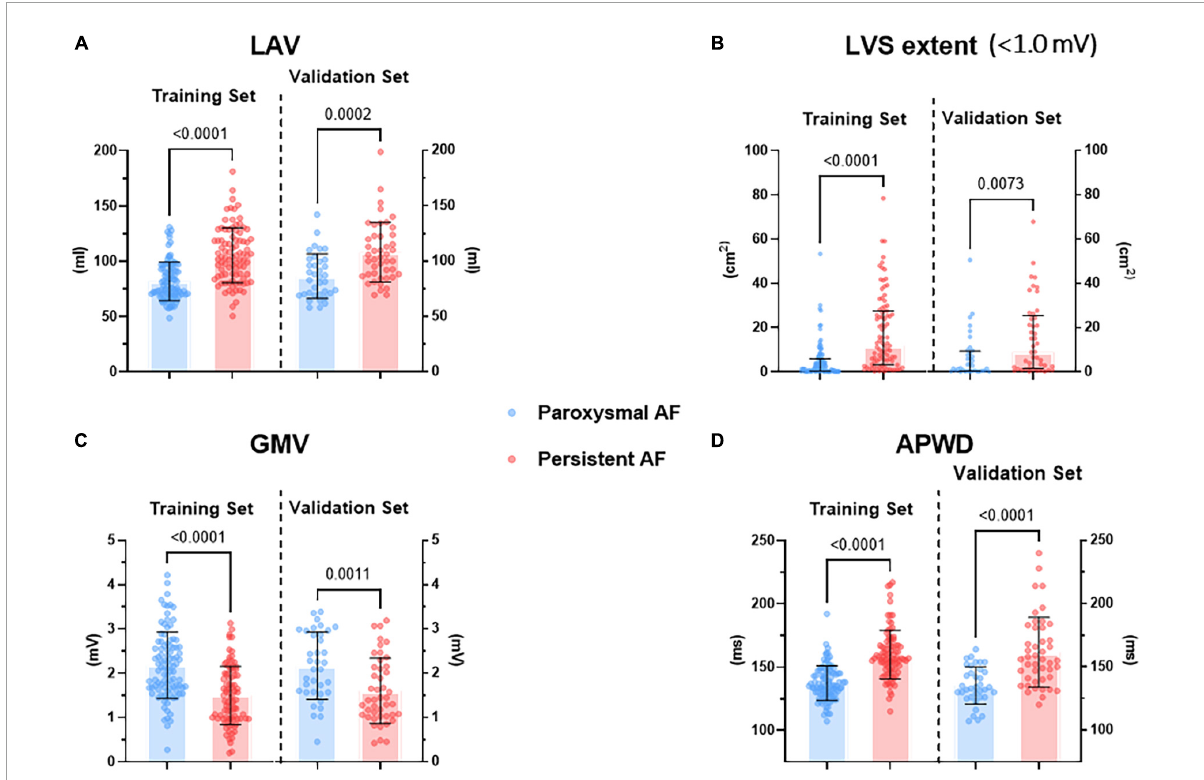
FIGURE2 Difference in selected parameters from each dimension between paroxysmal (blue) and persistent (red) AF cohorts in both training and validation sets. (A) Illustrates the difference in LAV, (B) illustrates the difference in LVS extent at < 1.0 mV threshold during sinus rhythm, (C) illustrates the difference in GMV, (D) illustrates the difference in APWD. LAV, left atrial volume; LVS, low voltage substrate; GMV, global mean voltage; APWD, duration of the amplified digital